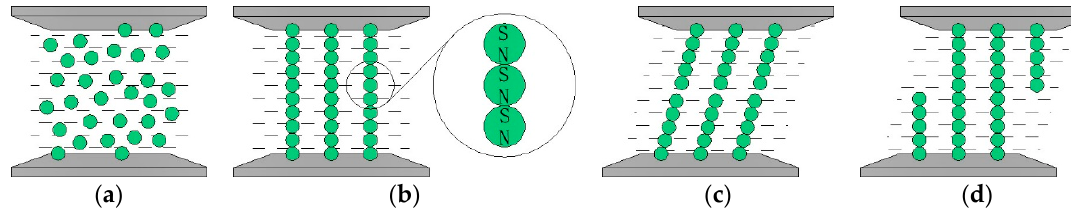
Figure 1. Shear motion of particles: ( a ) Initial state; ( b ) Chaining; ( c ) Stretching; ( d ) Reformation.